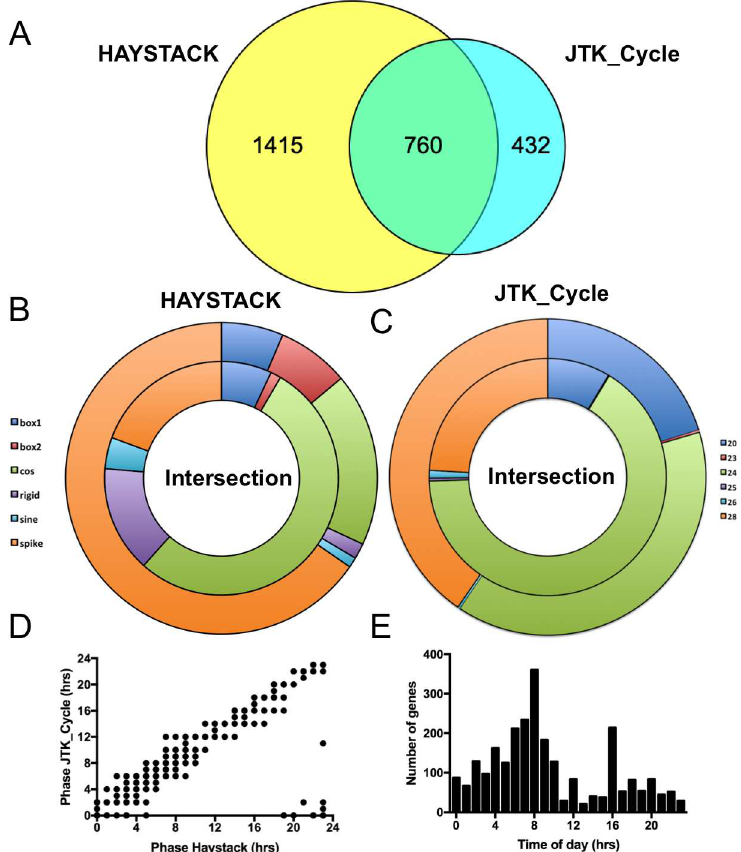
Fig 1. Rhythmic Zebrafish liver transcripts. (A) Venn diagram of rhythmic Zebrafish liver transcripts identifiedusing HAYSTACK and JTK_Cycle. (B) Differencein the shape of expressionprofile between transcripts identified by HAYSTACK alone or by both HAYSTACK and JTK_Cycle (Intersection in Fig 1A). Shapeslisted in legendare describedin [9]. (C) Differencein periodbetweentranscripts identified by JTK_Cycle alone or by both HAYSTACK and JTK_Cycle (Intersection in Fig 1A). Numbers in legend correspond to periodin hours. (D) Scatter plot of phaseof genes identified by HAYSTACK and JTK_Cycle. (E) Rhythmic transcript count by phaseof the